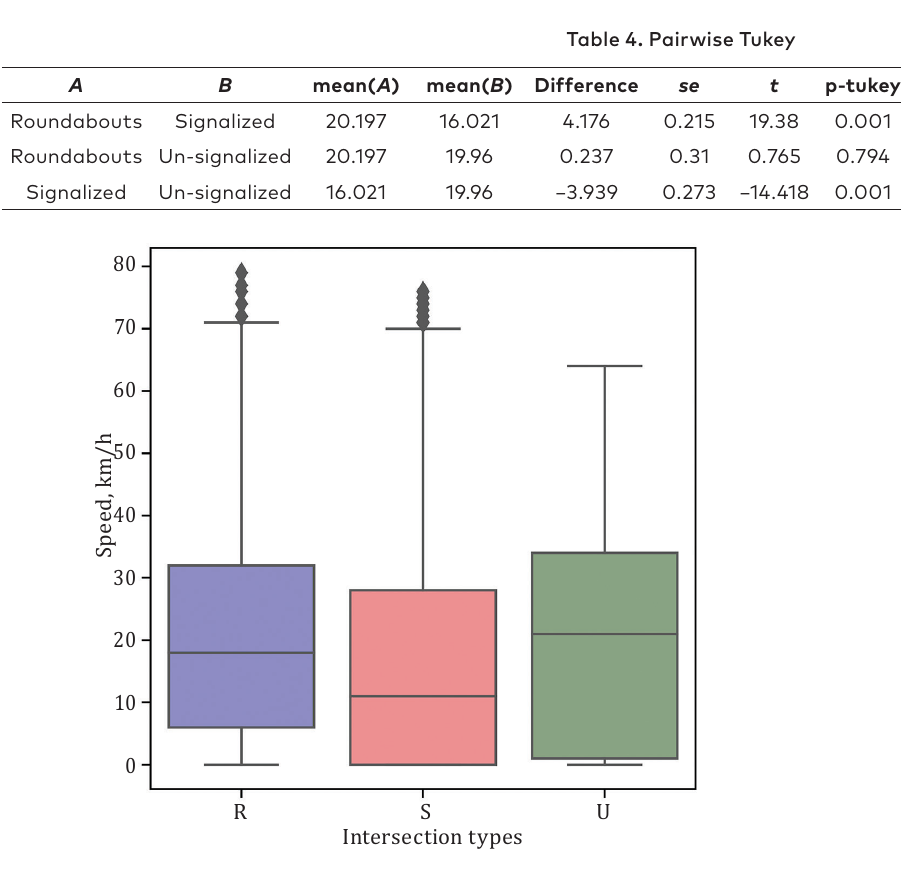
typesR S Figure 12. Mean speed at intersections Intersection